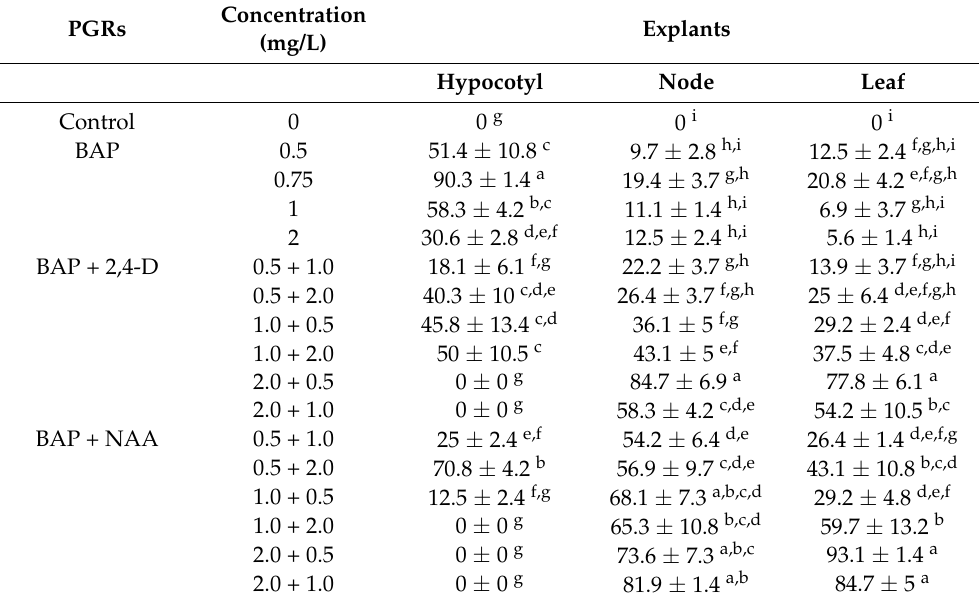
Table 2. Effects of different concentrations as well as combinations of PGRs on callus induction frequency from hypocotyl, node and leaf in D. purpurea . Concentration Explants PGRs (mg/L) Hypocotyl Node